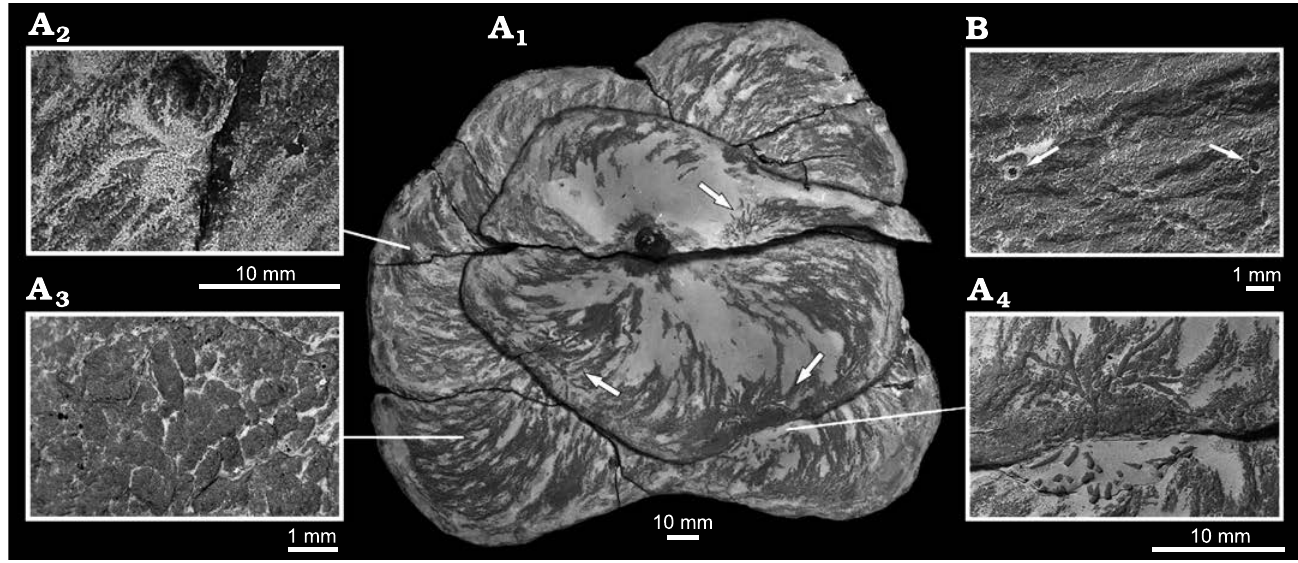
Fig. 7. Zoophycos brianteus Massalongo, 1855, with Chondrites intricatus (Brongniart, 1823). A . MZM Ge 32960, from Velká nad Veličkou, Czech Republic, Eocene. A 1 , bottom two coils of Z. brianteus , arrows mark specimens of Ch. intricatus ; A 2 , cylindrical structure penetrating a Z. brianteus sp- reite; A 3 , pellets on the surface of the spreite; A 4 , Ch. intricatus on the surface of a spreite. B . MZM Ge 32961, from Velká nad Veličkou, Eocene, minute shafts cross-cutting a Z. brianteus spreite, note the diagenetic halo around the